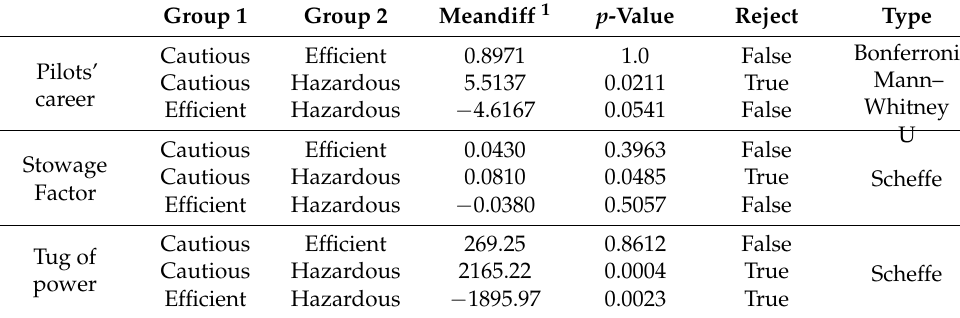
Table 12. Results of the post hoc